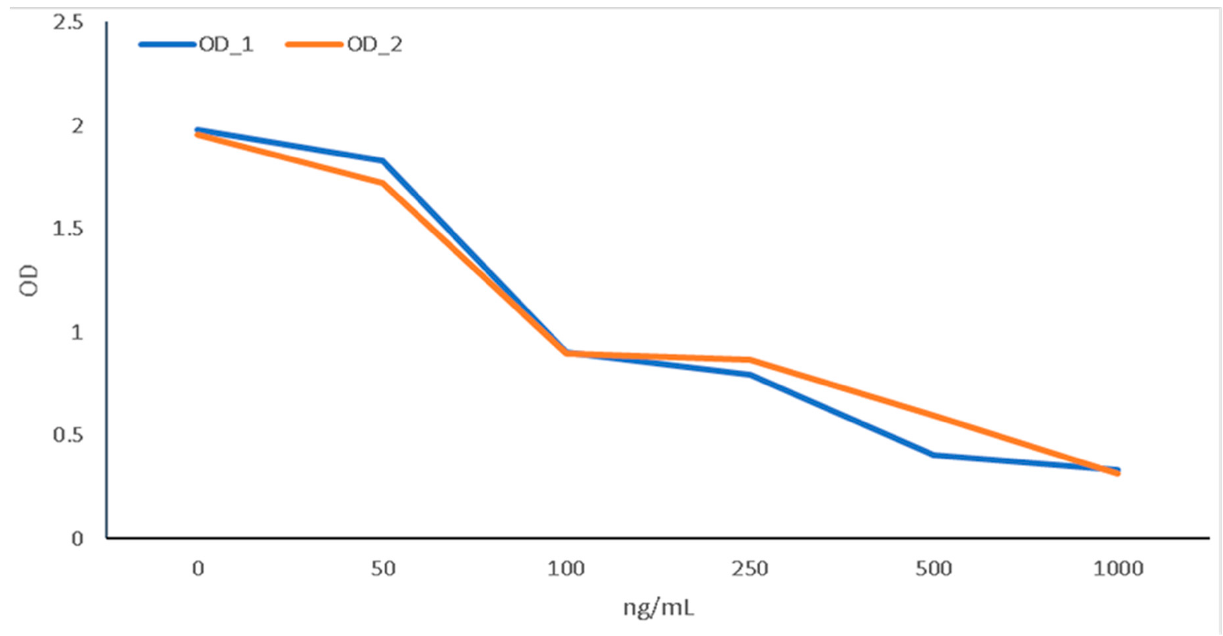
Figure 2. Optical density for first (OD_1) and second (OD_2) replicates of standards with known thrombin concentration (ng/mL).